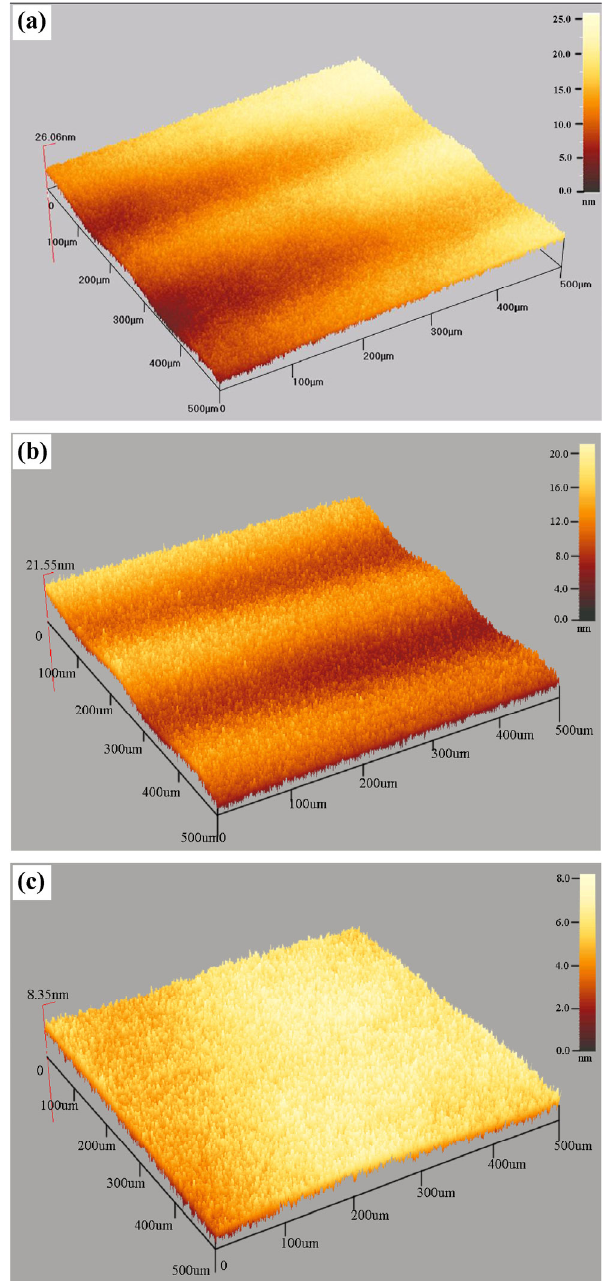
Fig. 6 Surface profiles of sapphire (a) before polishing (Ra = 3.62 nm), (b) polished by colloidal silica (Ra = 2.24 nm), and (c) polished by Ag-doped colloidal silica containing 1.5 wt% Ag 2 O (Ra = 0.85 nm). XPS test, and the green line was the total intensity after curve fitting by using the Thermo Avantage software. The overlap ratio between the real result (black line) and the fitting result (green line) contributed to more accurate measurement